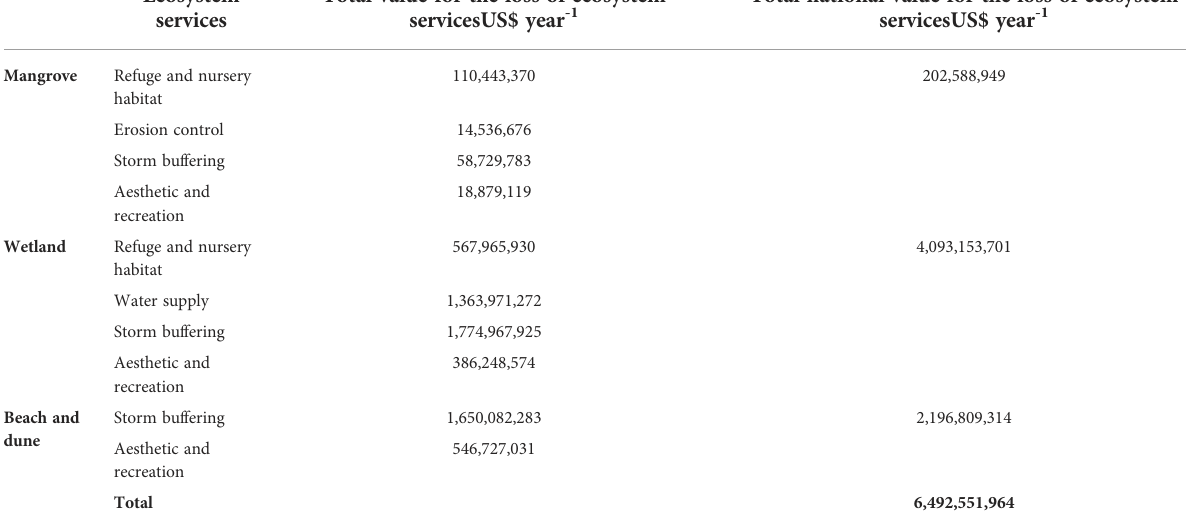
Total value for the loss of ecosystem servicesUS$ year -1